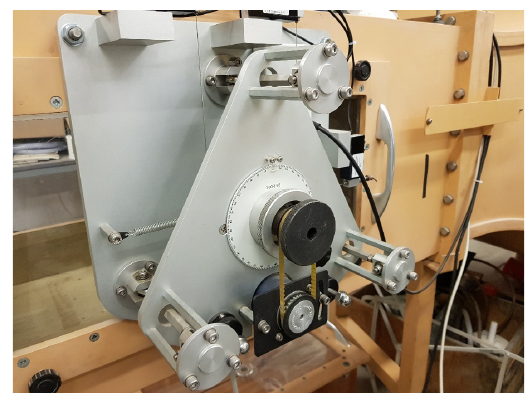
Figure 5. Three-point balance.